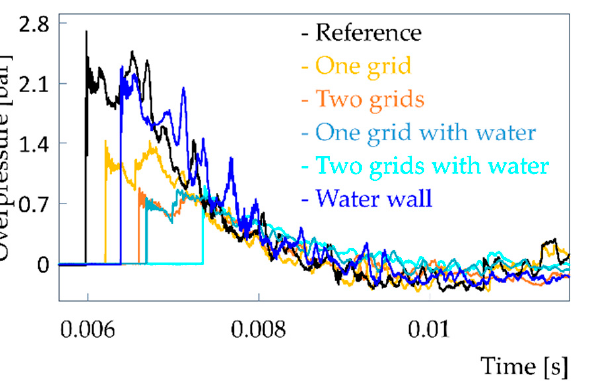
Figure 13. Reflected pressure measured on the wall for one test of each configuration. One reference test is also shown.